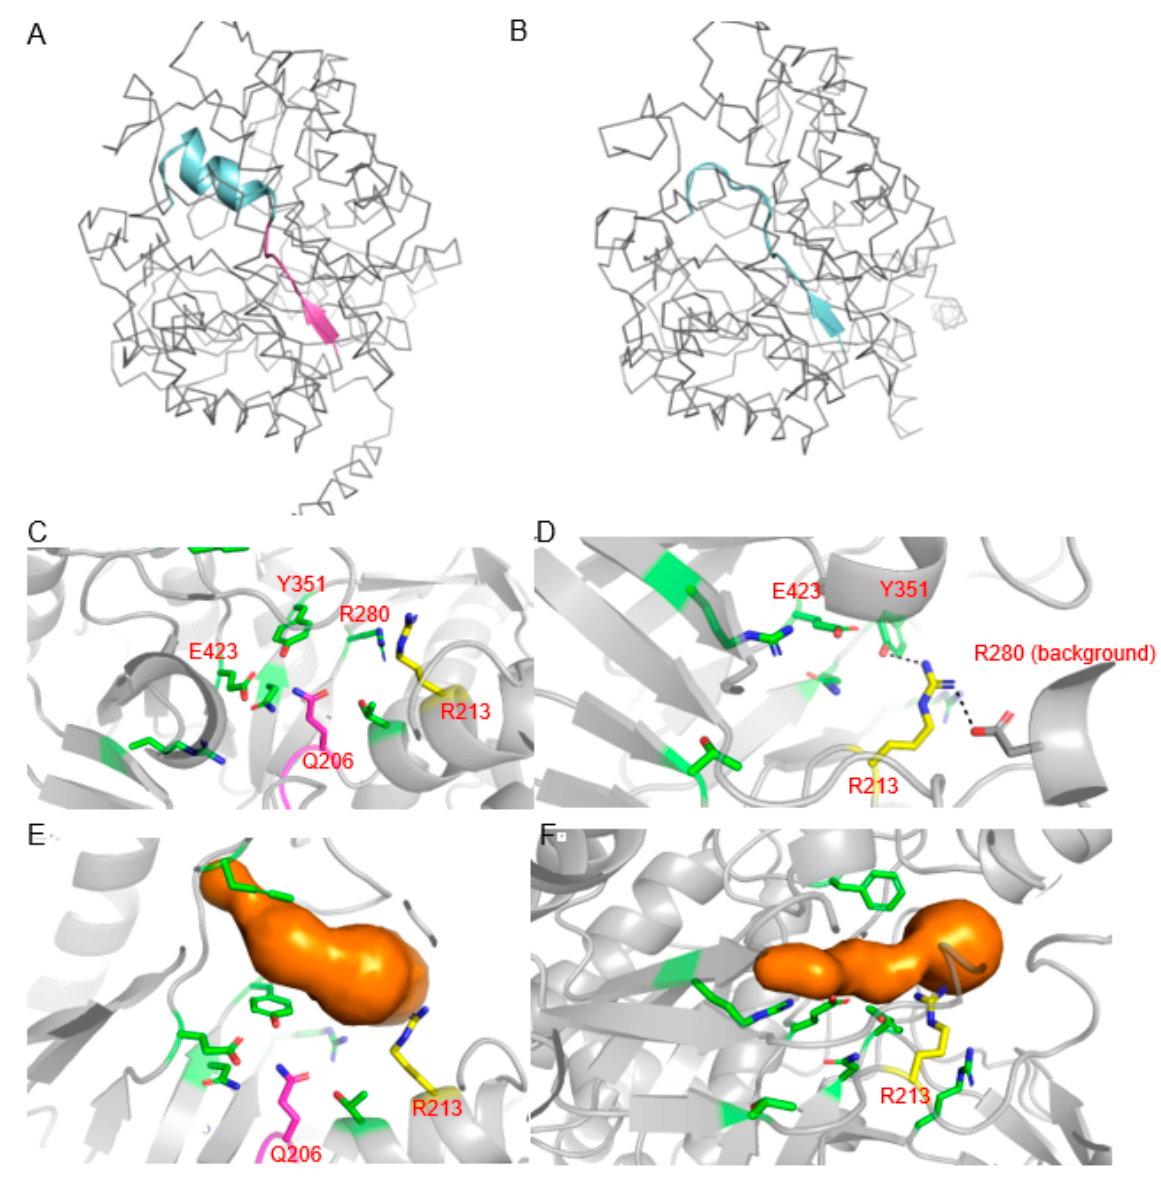
Figure 6. Overview of structural effects of the 21 bp deletion on myrosinase. In native myrosinase ( A ), the deleted region corresponds to a short beta strand and loop (magenta) that is immediately followed by a small alpha helix (cyan). Upon original beta strand and loop deletion, the former alpha helix (cyan) instead forms a new beta strand in the original strand’s position in place of an alpha helix ( B ). This deletion removes one of several catalytic residues, Q206 (magenta), previously identified in docking studies [23], and displaces R213 (yellow) formerly located on the downstream alpha helix ( C ). In the edited structure ( D ), this arginine is shifted closer to the catalytic glutamate and is predicted to extend further into the binding pocket; it is also predicted to interact with the sinigrin-binding residue Y351. When potential binding tunnels were identified using MOLE2.5 [30], the identified binding pocket ( E ) appears to narrow in the center in the edited protein ( F ) near the new position of R213.